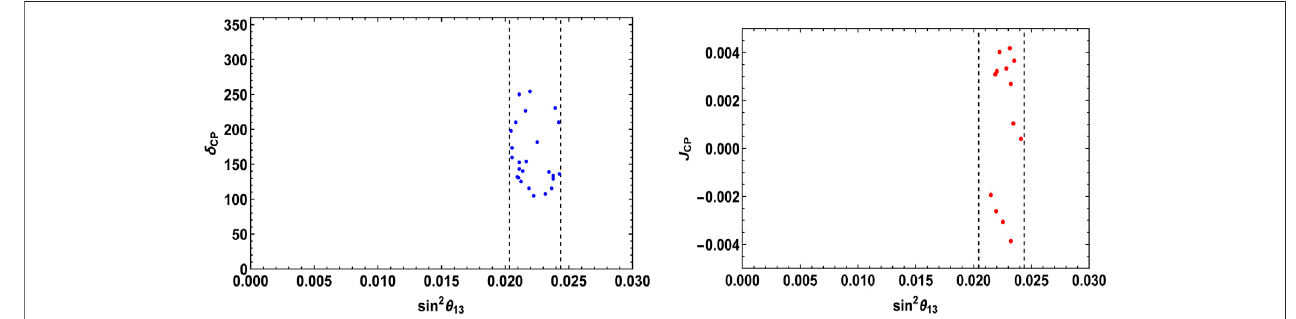
FIGURE 3 | Left (right) panel shows the plot of δ CP ( J CP ) with sin 2 θ 13 within its 3 σ